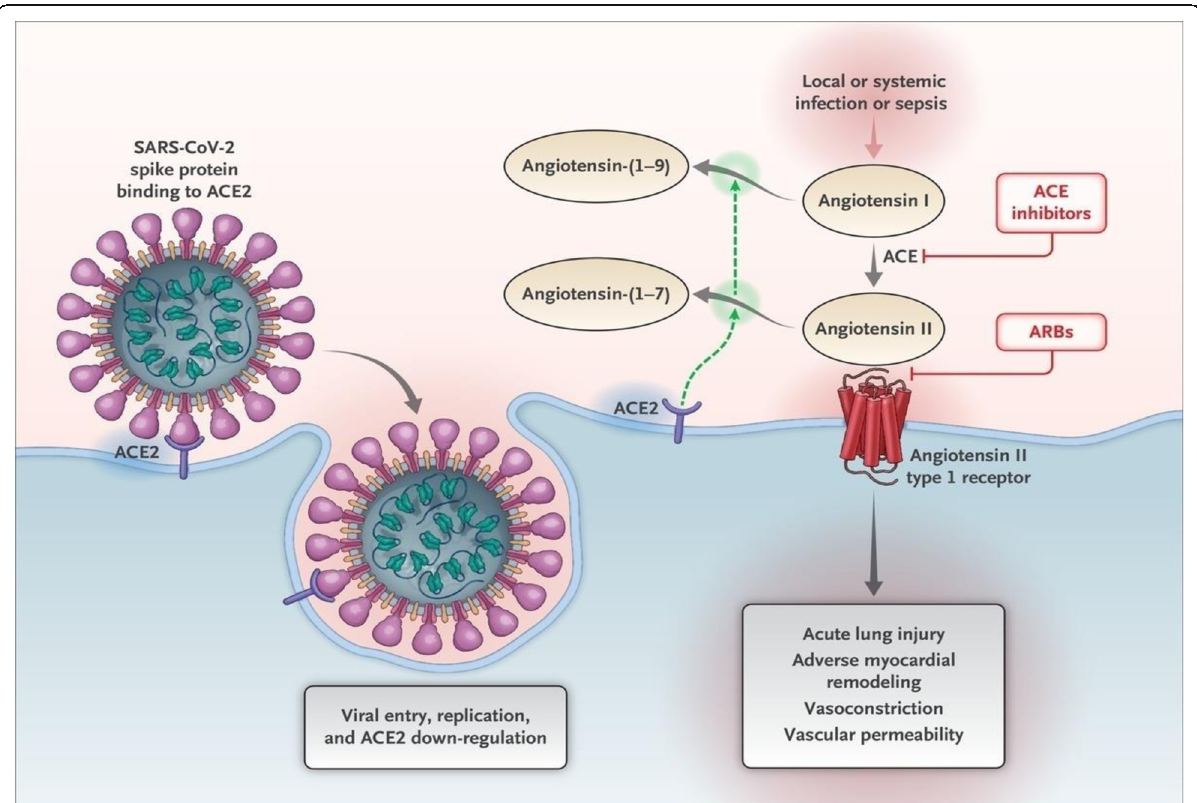
Fig. 1 Cell infection of SARS-CoV-2 and the role of renin-angiotensin-aldosterone system